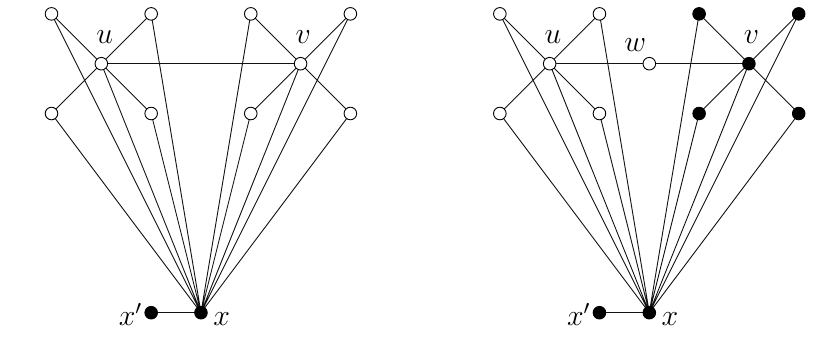
Fig. 3 Graphs G and G ⊕ w uv for k = 5.